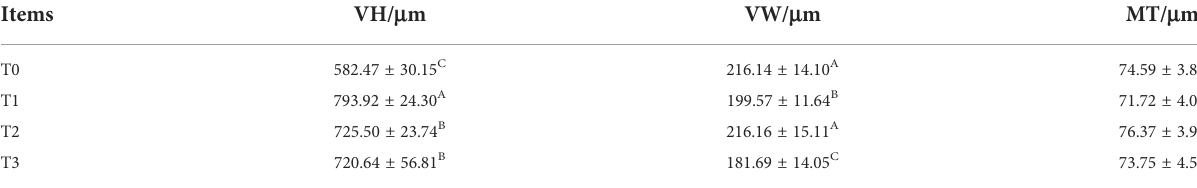
TABLE 5 Characteristics of midgut villi of largemouth bass. Items